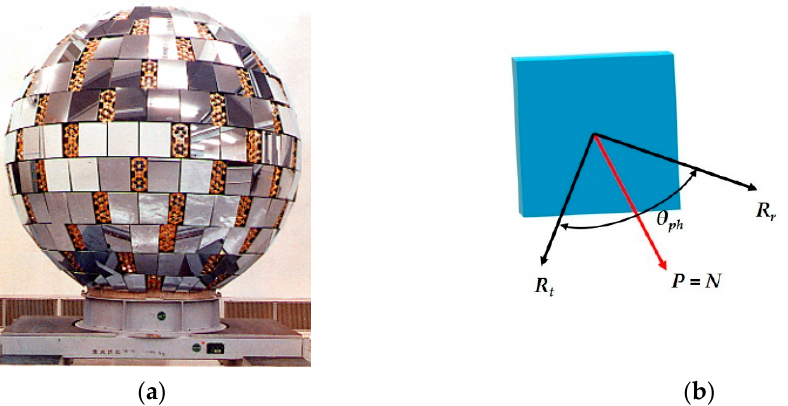
Figure 1. ( a ) Ajisai satellite (courtesy of JAXA) and ( b ) phase angle model of Ajisai’s convex mirror.